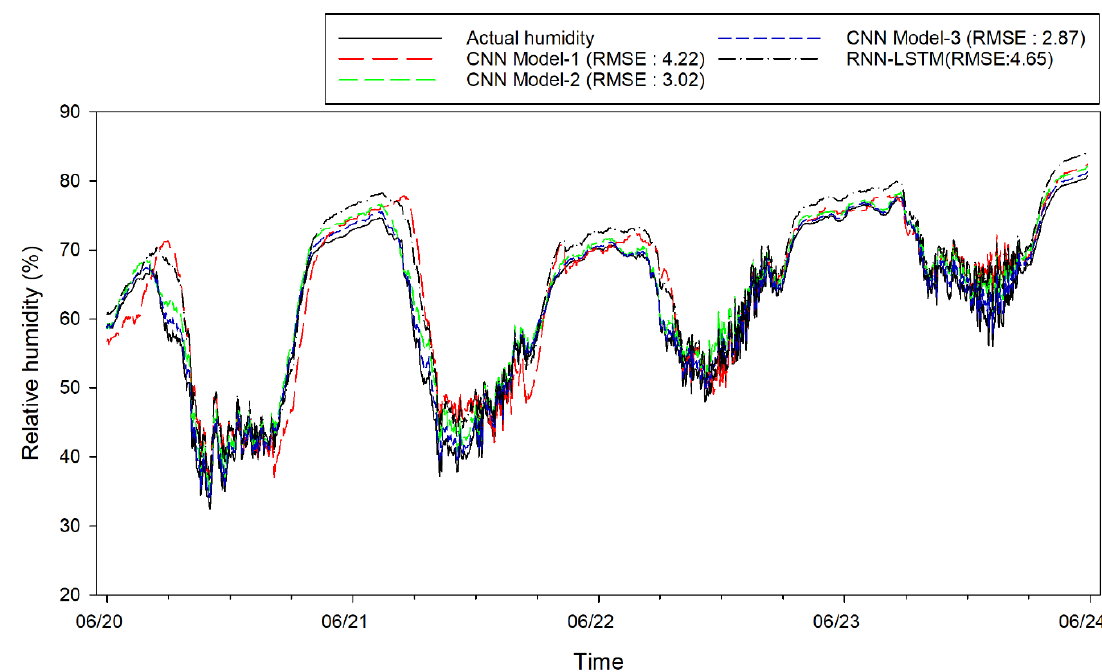
Figure 7. Test set results of 3 models to predict the relative humidity in the greenhouse.